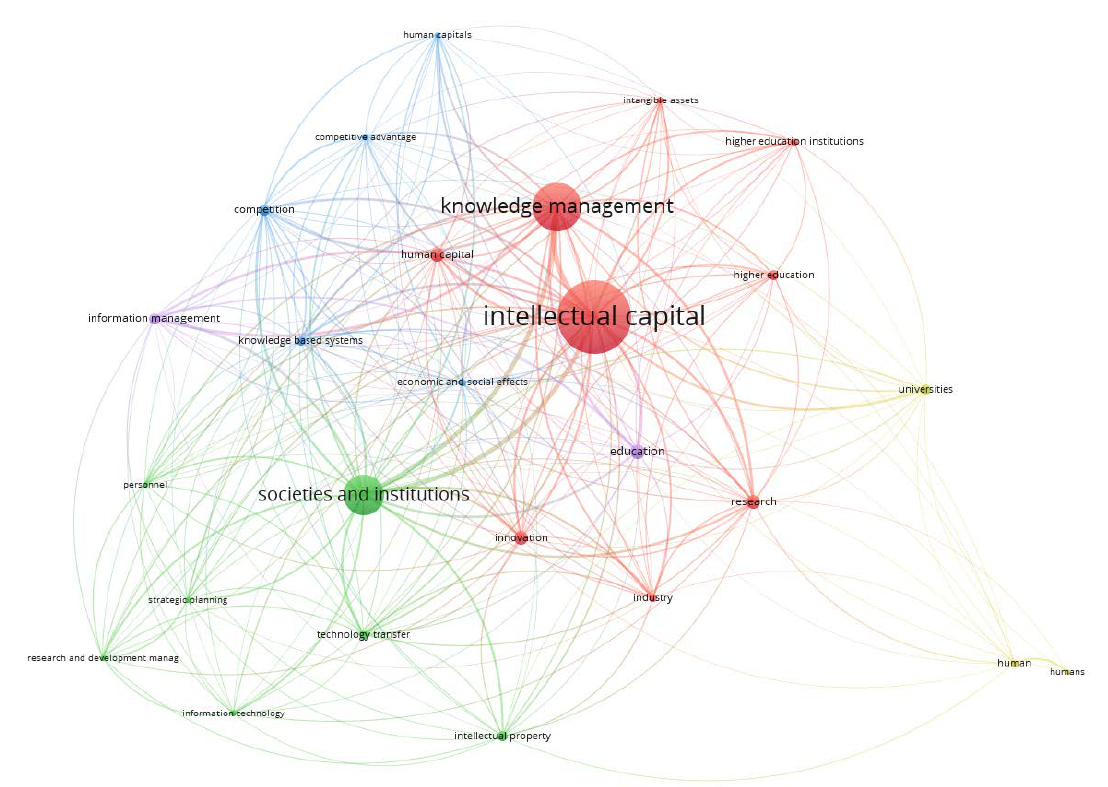
Figure 5. Co-occurrence between the keywords.